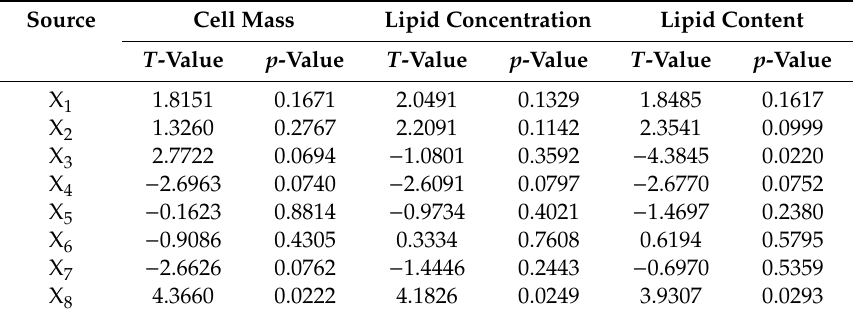
Table 1. Statistical analysis of factors using Plackett–Burman